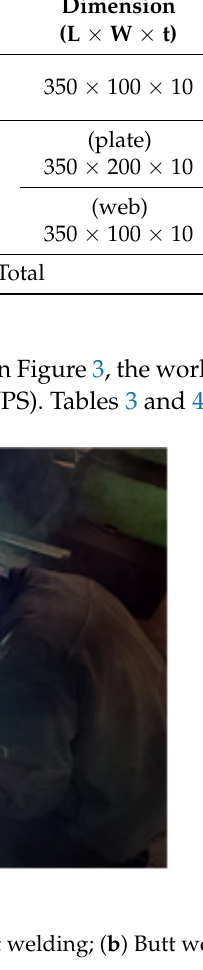
Table 3. Heat input parameter for making the fillet weld length.